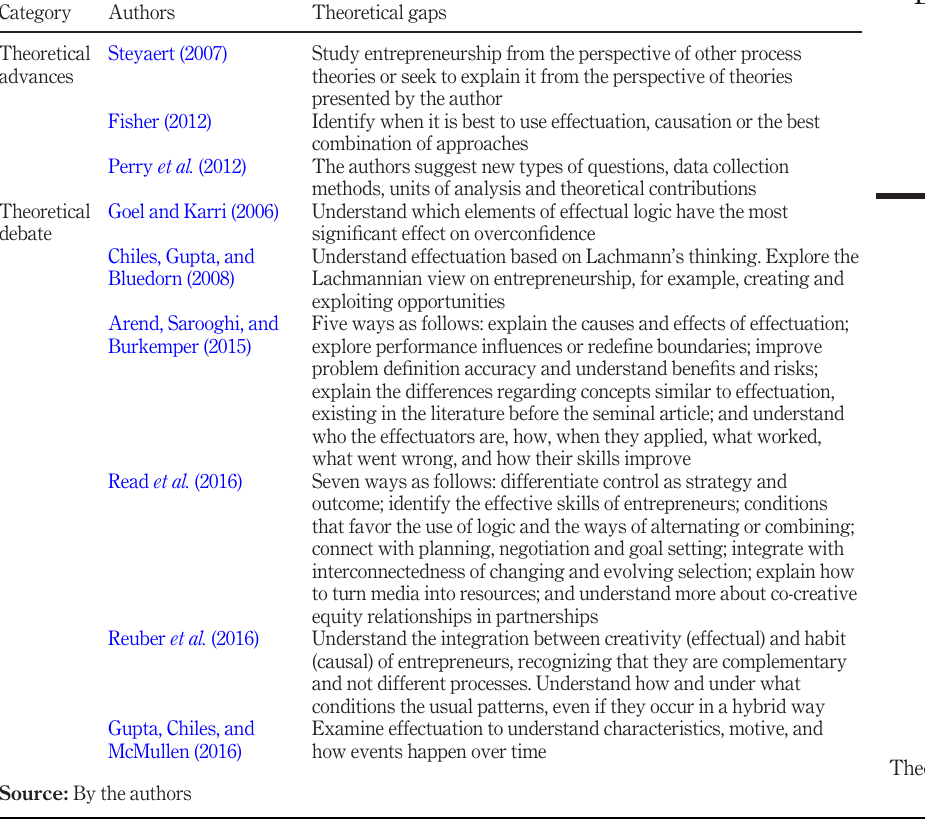
Table IV. Theoretical gaps